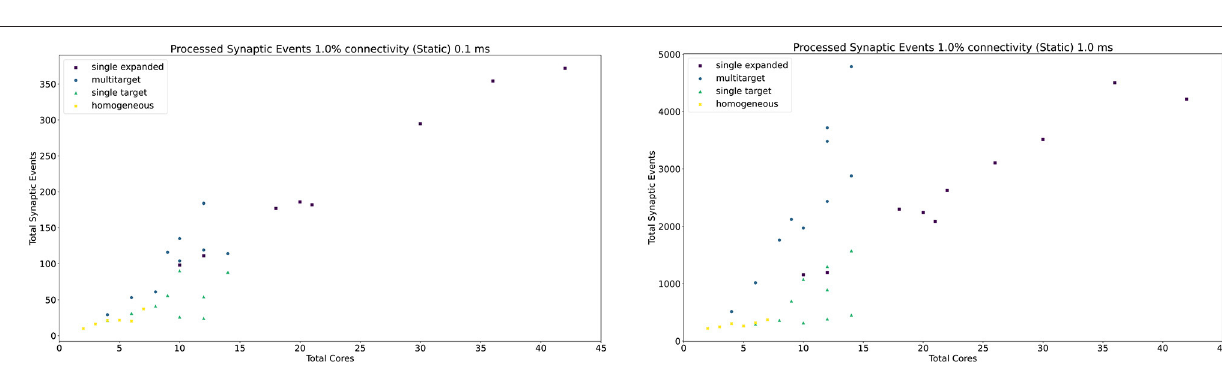
FIGURE 11 | Resource allocation vs. peak performance for the different partitioning strategies ( single target expanded , multi-target , single target , and baseline homogeneous). The network is the same used for Figure 10 , with 1% connectivity and static connections. The color scheme matches that used in Figure 10 . For a case by case labeled version of this plot, please refer to the Supplementary Material